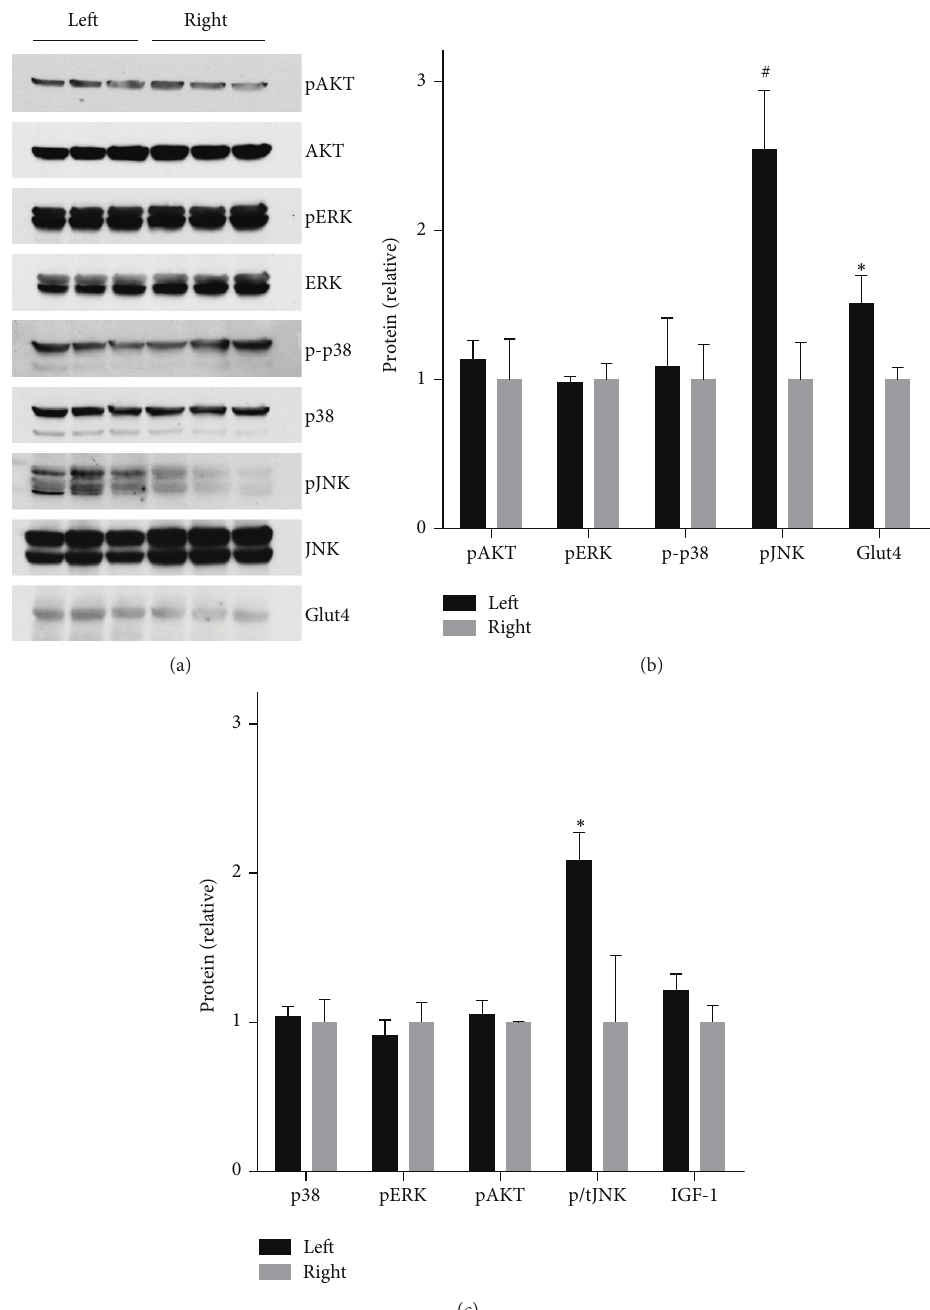
Figure 3: Myocardial protein levels in the heart from left (hyperglycemia exposed) and right (control) fetuses. (a) Western blot of phosphokinase and total kinase levels (AKT, ERK, p38, and JNK) and glucose transporter 4 (Glut4). (b) Quantitation of Western blot results. 𝑁 = 4 dams, 6 fetuses per side. ∗ 𝑃 < 0.01 , # 𝑃 < 0.005 . (c) Quantitation of Western blot results. 𝑁 = 1, 2, 3,2, 3 dams and 4,8, 12, 3, 12 fetuses/side for phospho-p38, phospho-ERK, insulin stimulated phospho-AKT, phospho-JNK normalized to total, and IGF-1, respectively. ∗ 𝑃 < 0.01 . (a-b) Dams infused with left uterine artery hyperglycemia on gestational days 19-20. (c) Dams infused with left uterine artery hyperglycemia on gestational days